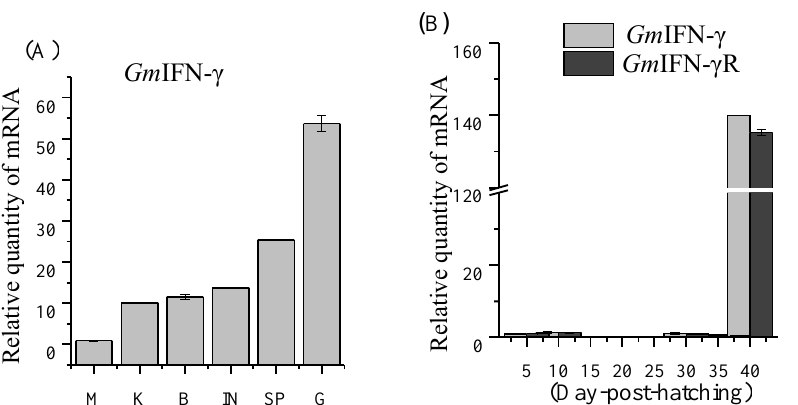
Figure 3. Expression profiles of GmIFN– γ . ( A ) Expression levels of GmIFN– γ in adult Pacific cod Fig. 3. Expression profiles of GmIFN-γ . (A) Expression levels of GmIFN-γ in adult Pacific cod’s muscle (M), kidney (K), brain (B), intestine (I), spleen (SP) and gill (G). ( B ) Expression pattern of GmIFN– γ and its receptor in cod larvae during the early developmental muscle (M), kidney (K), brain (B), intestine (I), spleen (SP), and gill (G). (B) Expression pattern of Gm IFN-γ and its receptor in cod larvae during the early developmental stages.